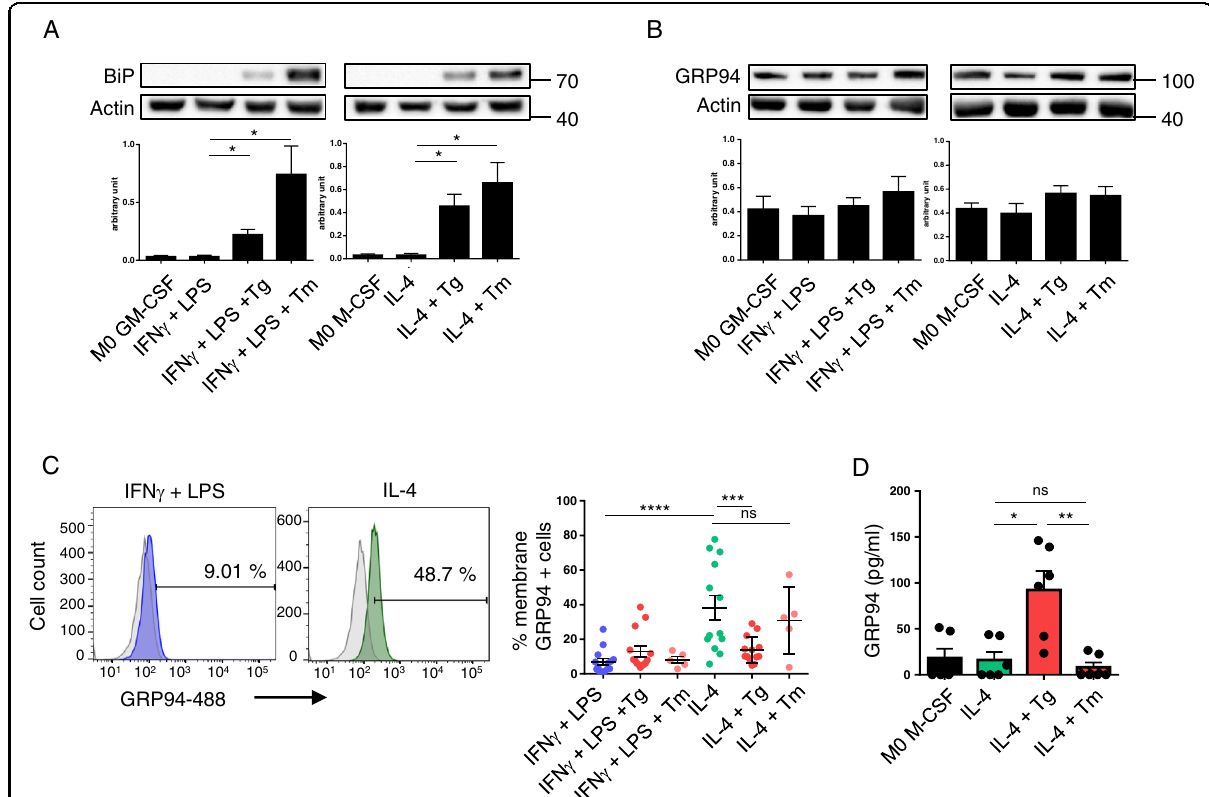
Fig. 1 GRP94 expression by M1 (IFN γ -LPS) and M2(IL-4) macrophages treated or not with Tg or Tm. M1 and M2 macrophages derived from PBMC of healthy volunteers were activated in the presence of GM-CSF and M-CSF, respectively. Tg (25 nM) or Tm (100nM) was added to cell cultures during all the activation period. A , B Western blot analysis ( n = 4) of BiP ( A ) and GRP94 ( B ) in M1 and M2 activated macrophages (24 h) treated or not with Tg or Tm. C Left panel, GRP94 membrane expression on 48 h activated M1 and M2 analyzed by FACS; Right panel, histograms of GRP94 membrane expression in M1 and M2 macrophages under basal or Tg or Tm conditions ( n = 14 donors except for Tm n = 5). D GRP94 quanti fi cation by ELISA in macrophages M2 cell culture supernatants activated for 48 h and treated or not with Tg or Tm ( n =